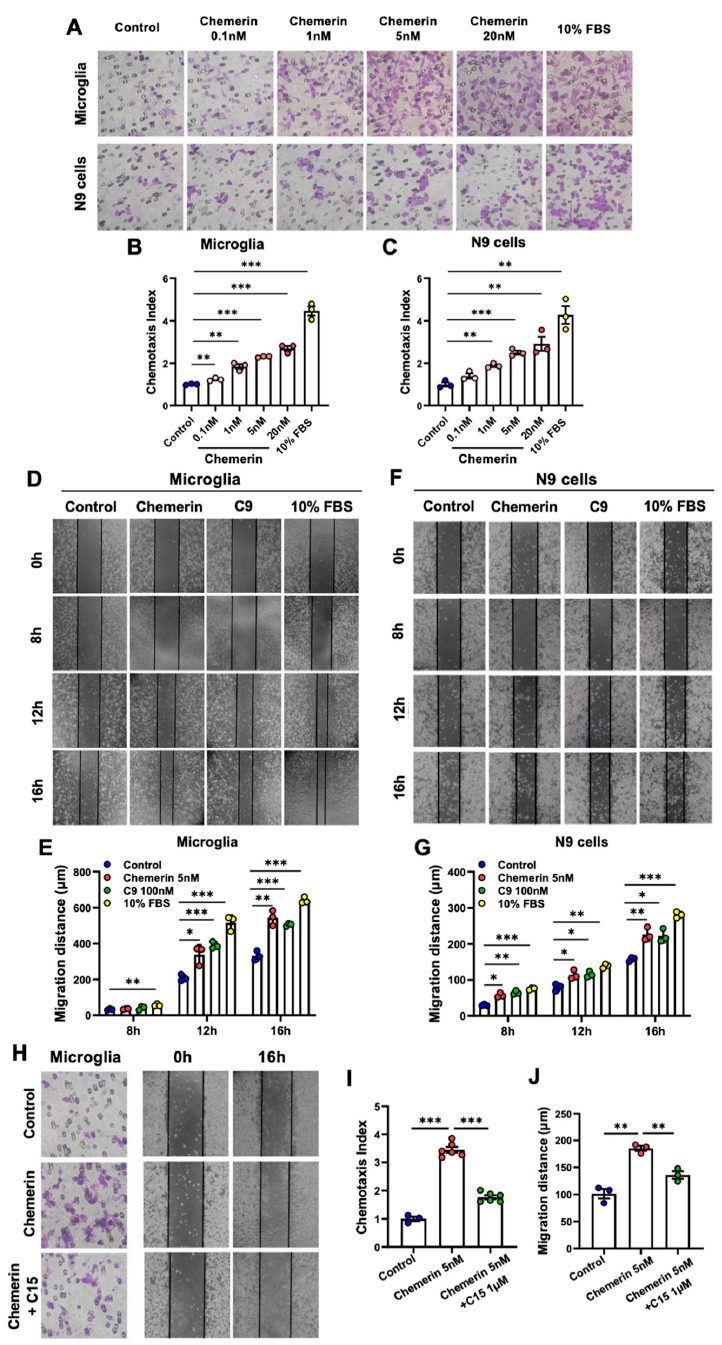
Figure 3. Chemerin/CMKLR1 axis promotes the migration of microglia in Boyden chamber migration and scratch-wound assay. ( A ) Primary cultures of microglia and murine microglial N9 cells were incubated for 12 h with chemerin (0.1–20 nM) or 10% FBS, and the migration of the cells was evaluated by 48-well chemotaxis chambers. Representative images of migrated cells on membrane filters are shown. ( B , C ) The Quantified data are shown. Magnification, ×400. Primary microglia and N9 cells were treated with chemerin (5 nM), C9 (100 nM), or 10% FBS; then, the migration of the cells was detected by scratch-wound assay. The microglia were photographed at 0 h, 8 h, 12 h, and 16 h. Representative images of migrated primary microglia and N9 cells are shown in ( D , F ), and